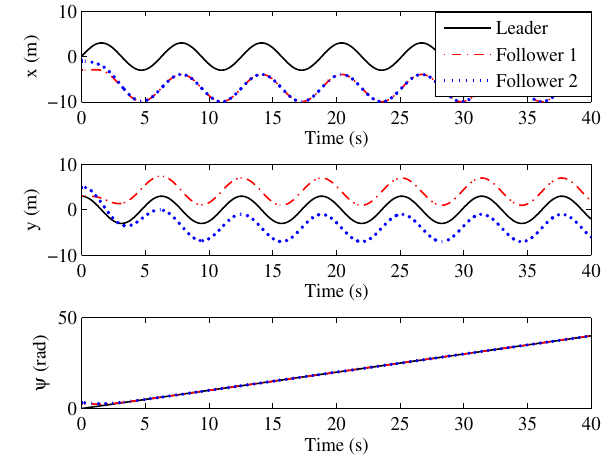
Figure 7. Positions and attitudes of follower 2 and follower